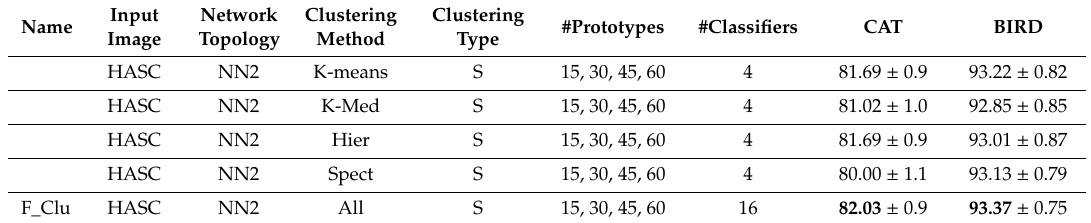
Table 3. Performance obtained considering different clustering algorithms: accuracy ± standard deviation.